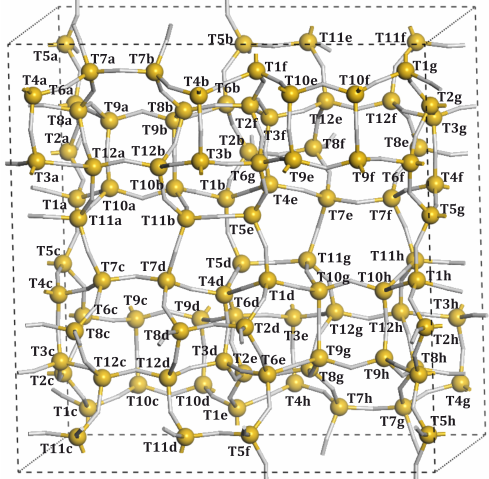
Figure 3. MFI unit cell with labelled T